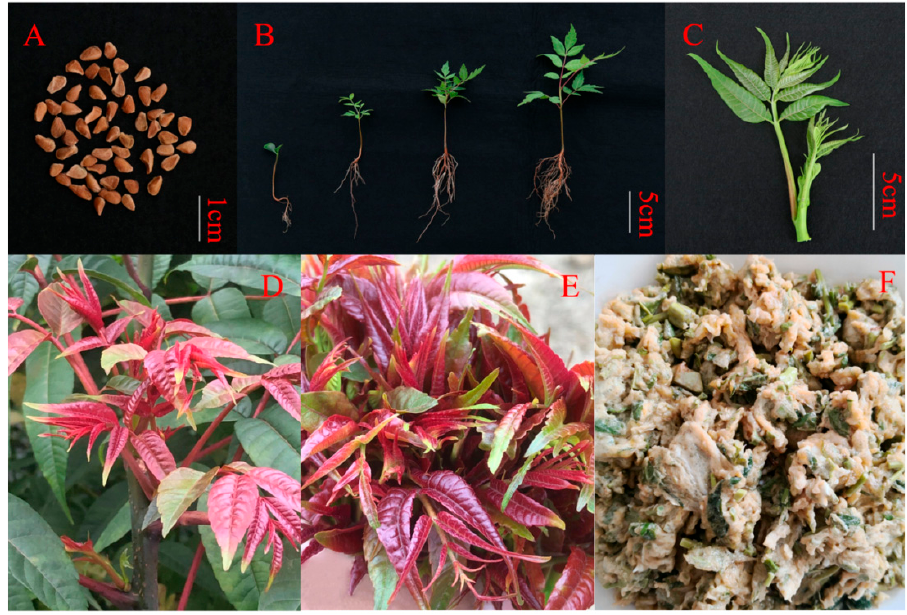
Figure 1. Seeds ( A ), seedlings ( B ), plant and buds ( C – E ) of T. sinensis , and cooked with eggs ( F )